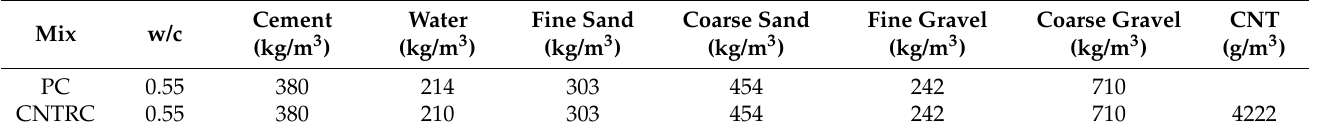
Table 3. Concrete